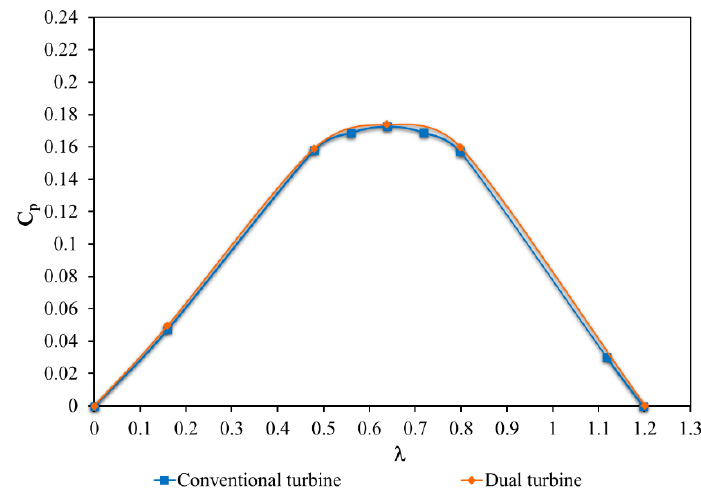
Figure 8. The power coefficients of the reference conventional and dual turbine. The effect of the triangular plate tip width on the torque coefficient variation in a triangular plate dual turbine design is shown in Figure 9. The changes in the resulting torque coefficients were determined from a complete turbine rotation after the turbine entered the stable regime. In order to compare the results obtained, the value of the turbine tip speed ratio was taken as constant, i.e., 0.638. The other geometric parameters were also taken as constant to examine the effect of the triangular plate tip width on the torque coefficient. According to this, the distance between the turbine axes was taken according to 2.2 of the c/D ratio, the triangular plate base width was taken according to 2 of the b/D ratio, and the distance between the triangular plate and the turbine axes was taken according to 0.6 of the a/D ratio. With the values of 0.3, 0.5, and 0.9 of the ratios of the triangular plate end width to the triangular plate base width (w/b), narrow (60 ◦ ), perpendicular (90 ◦ ), and wide (120 ◦ ) triangular plate tip angles were formed, respectively. As can be seen from the figure, it was determined that the highest torque change was obtained when the w/b ratio of the triangle plate tip width was 0.5. Moreover, the lowest torque change was achieved if the w/b ratio of the triangular plate tip width was 0.3. When the obtained torque changes were examined, the best torque values were obtained compared to the other angles if the triangular plate tip angle was 90 ◦ , i.e., the w/b ratio was 0.5.